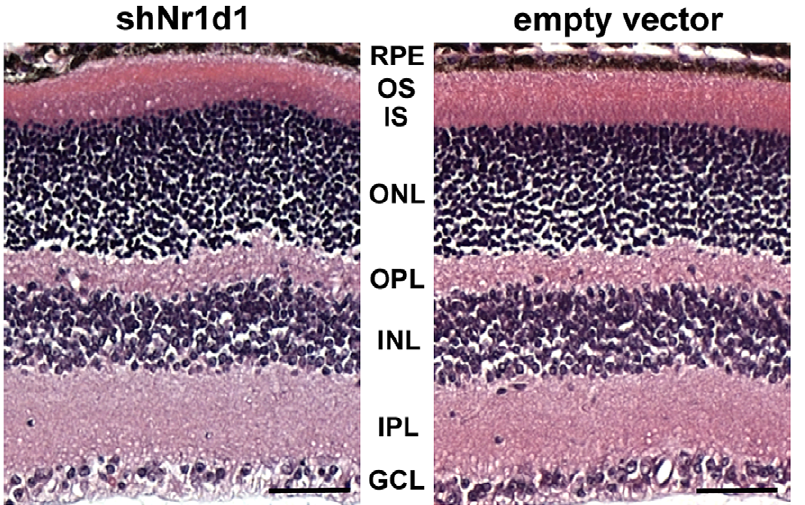
Figure 4. Hematoxylin and Eosin staining of shNr1d1 injected retinas does not reveal morphological abnormalities. shNr1d1 and vector only injected mice were aged to postnatal day 30.5 for analysis by Hematoxylin and Eosin staining. No gross structural abnormalities were observed in eyes injected with shNr1d1 when compared to vector only controls. RPE: retinal pigmented epithelium, OS: outer segments, IS: inner segments, ONL: outer nuclear layer, OPL: outer plexiform layer, INL: inner nuclear layer, IPL: inner plexiform layer, GCL: ganglion cell layer. n=3. Scale bar =50 m m.